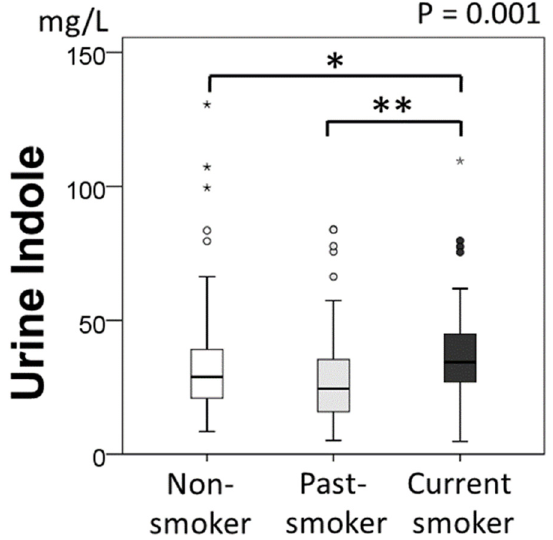
Figure 2. Comparison of urine indole levels by smoking status. The p -value on the graph stands for the statistical significance of difference among three groups ( p = 0.001). * p < 0.05, ** p < 0.01.